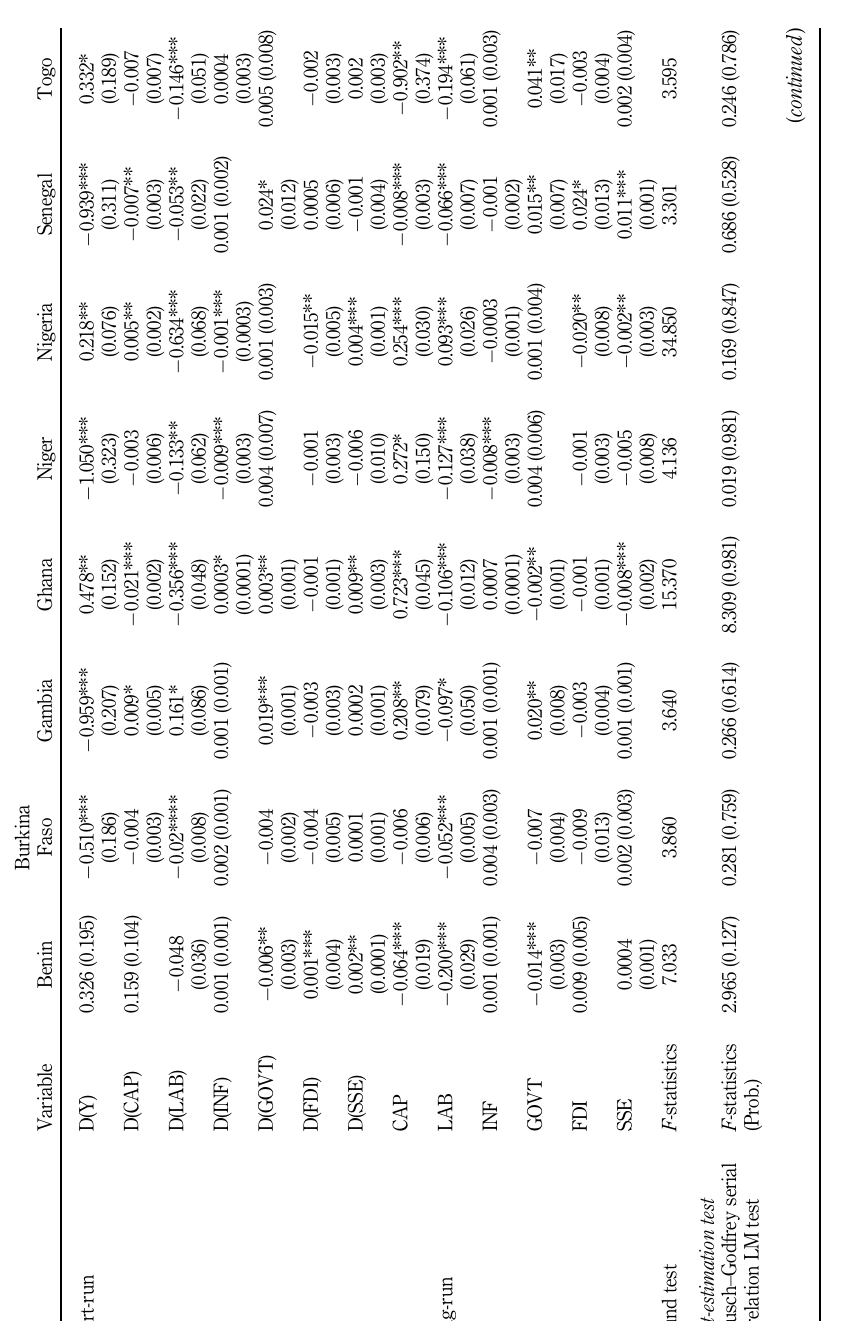
Table 3. Models with